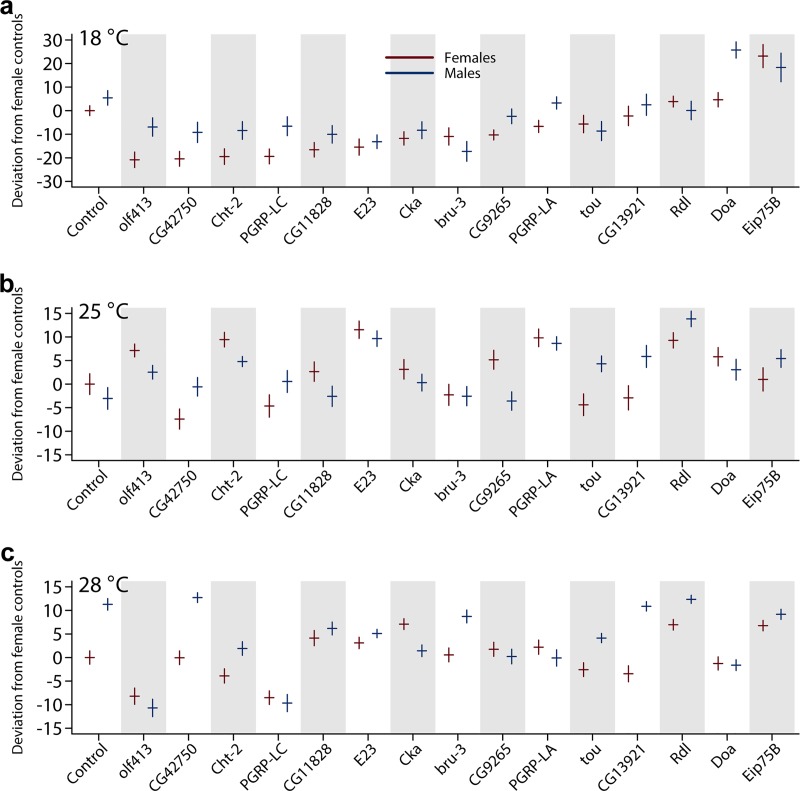
RNAi functional assessments of candidate genes.Mean (horizontal lines) ± one standard error (vertical lines) of life span of RNAi genotypes and their controls in each temperature. Life span is expressed as the deviation from the mean of the female control flies in each temperature such that the relative magnitude of life span is retained across temperatures. The genes on the x axis are ordered based on the mean of female life span at 18°C. Red = females and blue = males. (A) 18°C; (B) 25°C; (C) 28°C. P values of differences between sexes, genotypes, and temperatures are given in S8 Table. The raw data for the information depicted in this figure are available at https://github.com/qgg-lab/dgrp-lifespan/. RNAi, RNA interference.